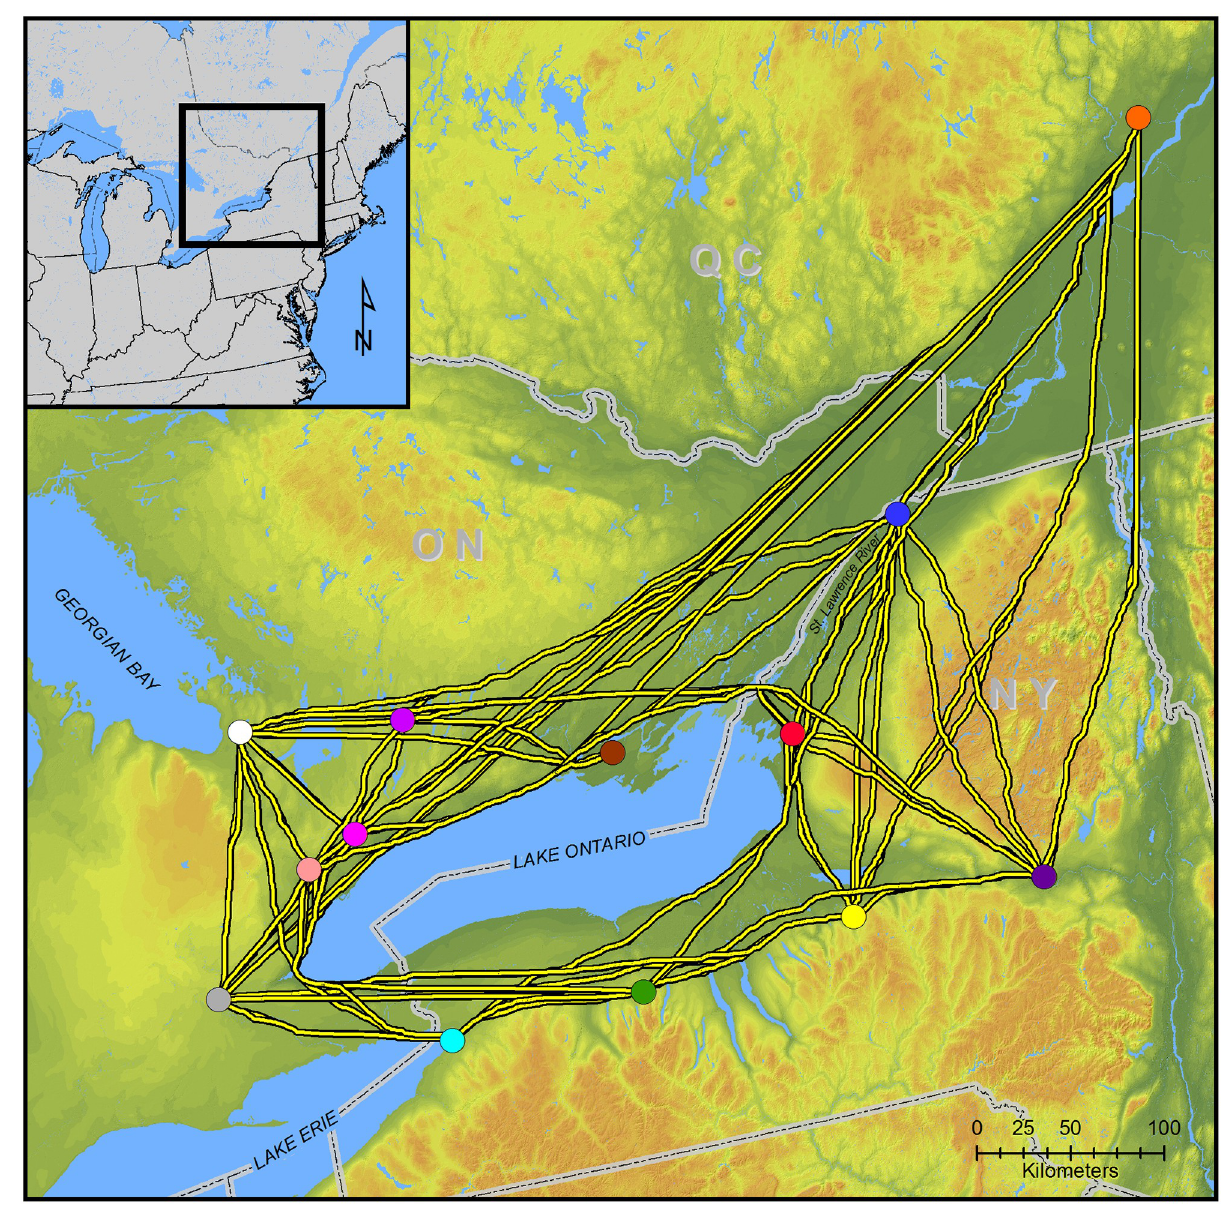
Fig 3. Least cost paths between geographic cluster